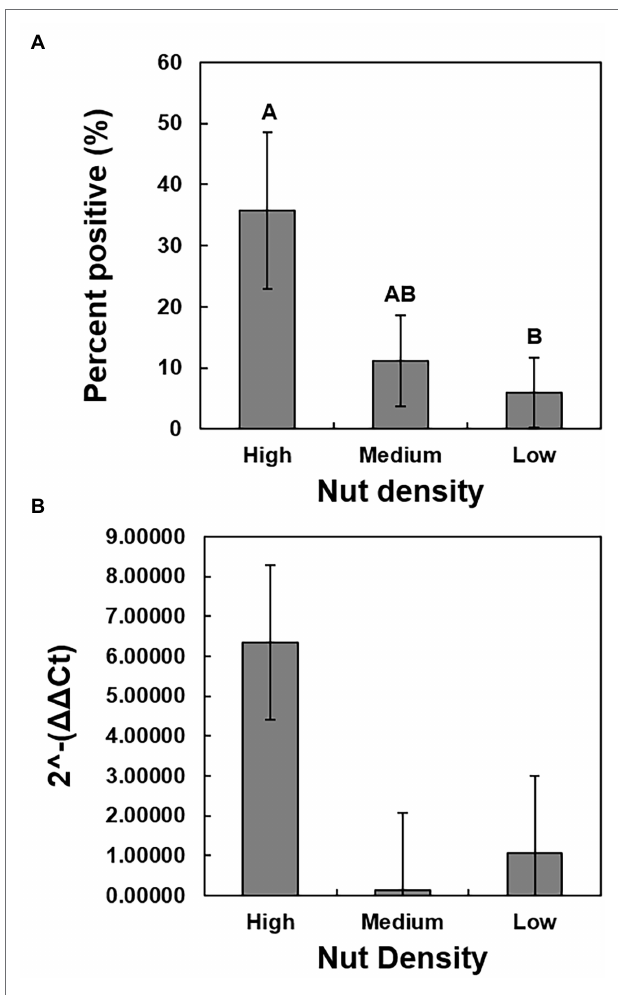
FIGURE 4 | The relationship between seed density and the presence and concentration of X. fastidiosa . A total of 150 seeds were collected from pecan bacterial leaf scorch-diseased tree of cultivar Cape Fear and separated by density into three groups, based on seed density. The average seed density of each group was as follows: high-density seed (0.72 g/cm 3 ), medium- density seed (0.62 g/cm 3 ), and low seed density (0.52 g/cm 3 ). Prior to planting, the seeds were bisected, and the section not containing the embryo was harvested and the gDNA isolated. qPCR analysis was performed on a subset of 25 seeds per group to determine the presence of X. fastidiosa . (A) The incidence (%) of seeds that tested positive for the presence of X. fastidiosa . (B) The 2 - ΔΔ Ct of X. fastidiosa DNA amplification normalized to pecan DNA amplification in the high-, medium-, and low-density seeds. Error bars indicated standard errors of the mean values. Means with different letters are significantly different based on Tukey’s HSD ( α =